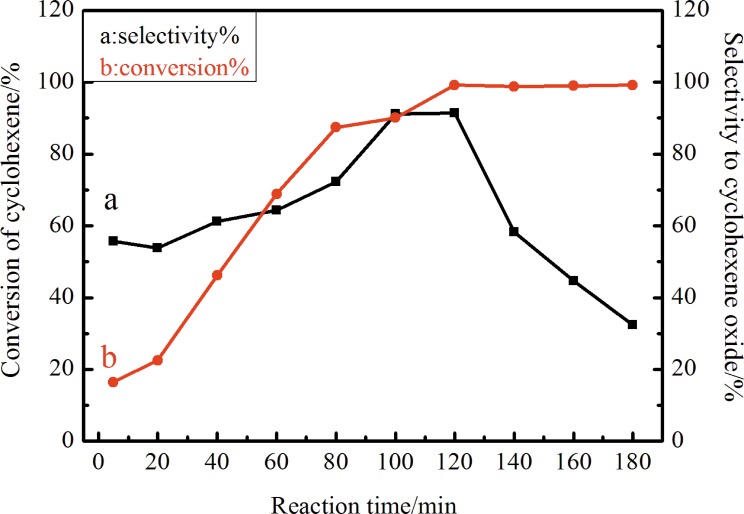
Effect of reaction time on the catalytic performance of Ag-TiO2-SiO2 in the epoxidation of cyclohexene.(Reaction conditions: catalyst, 80 mg; cyclohexene, 6 mL; H2O2, 6 mL; chloroform, 12 mL; at 353 K).